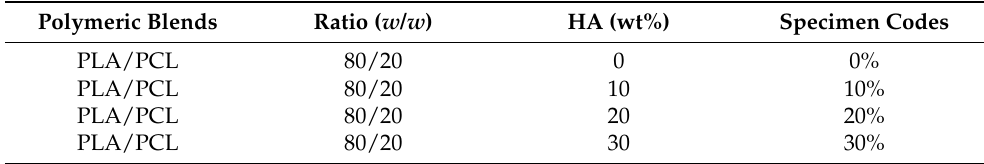
Table 2. Label and composition of biocomposite